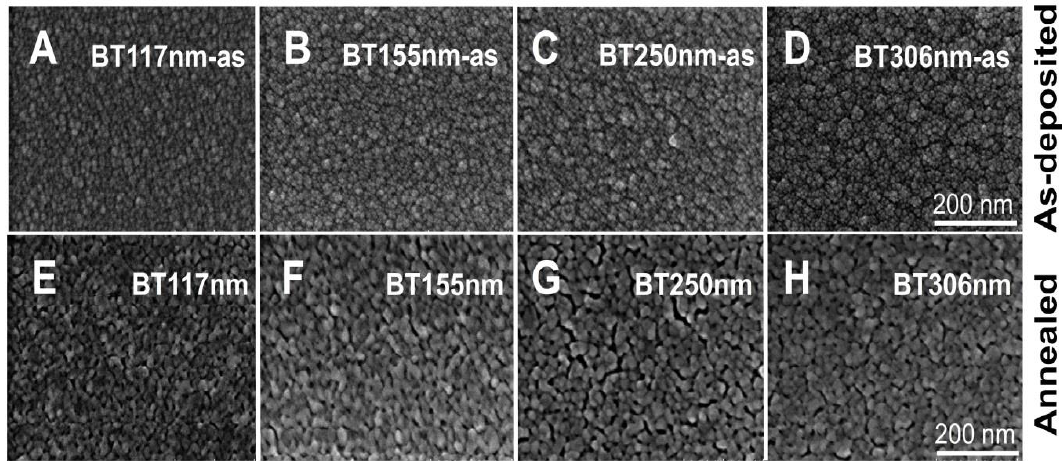
Figure 1. Field-emission scanning electron microscopy of TiO 2 (B) films. Examples of the vertical views ( A – H ) of TiO 2 (B) films with various thickness, before ( A – D ) and after ( E – H ) annealing.